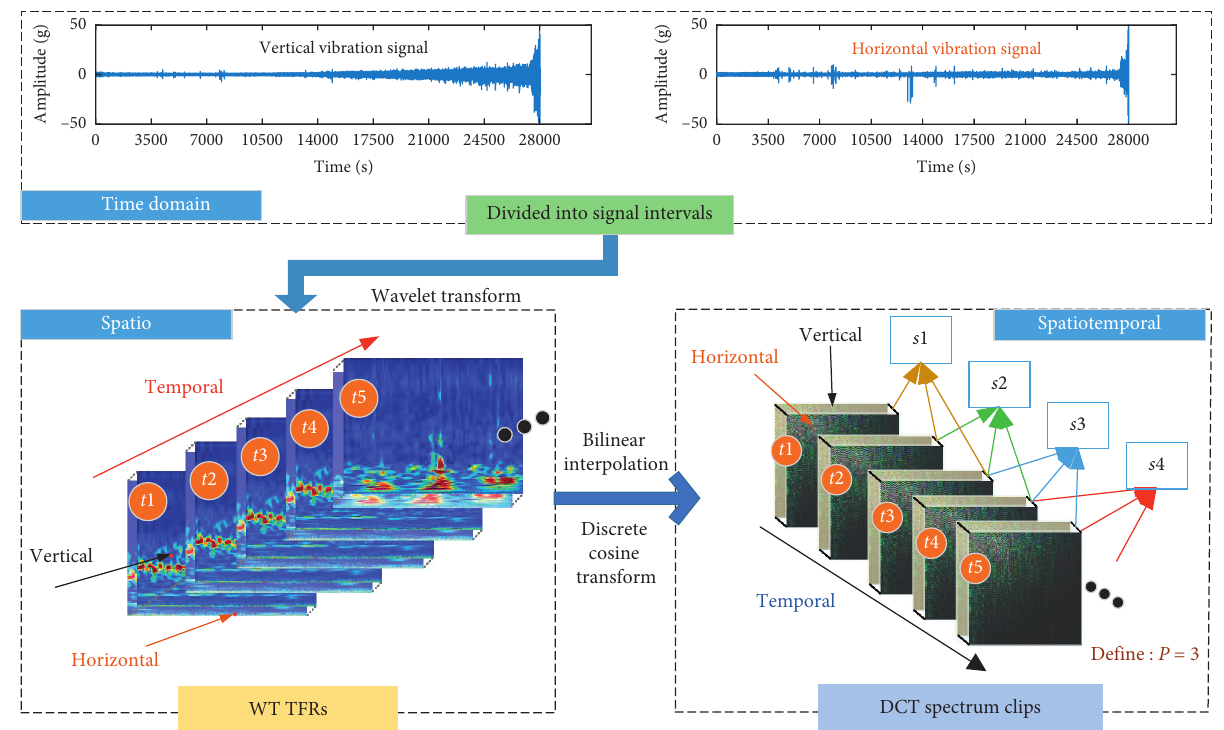
Figure 3: Schematic diagram of the generated continue DCT spectrum stream.